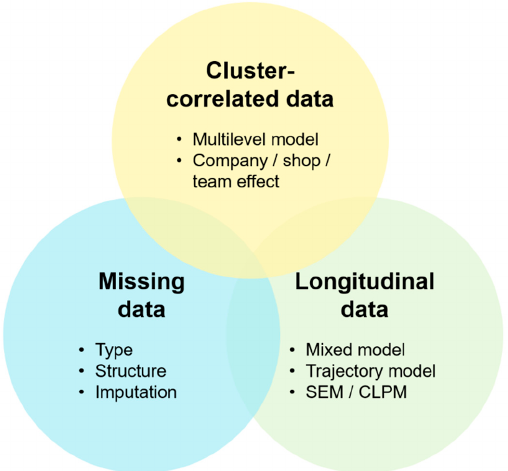
Figure 1. Data diversity of real-world longitudinal occupational health databases (see Appendix A for the novelty and usefulness of our approach and main formulas surrounding cluster-correlated data, missing data, and longitudinal data). SEM: structural equation model, CLPM: “cross-lagged” panel model.